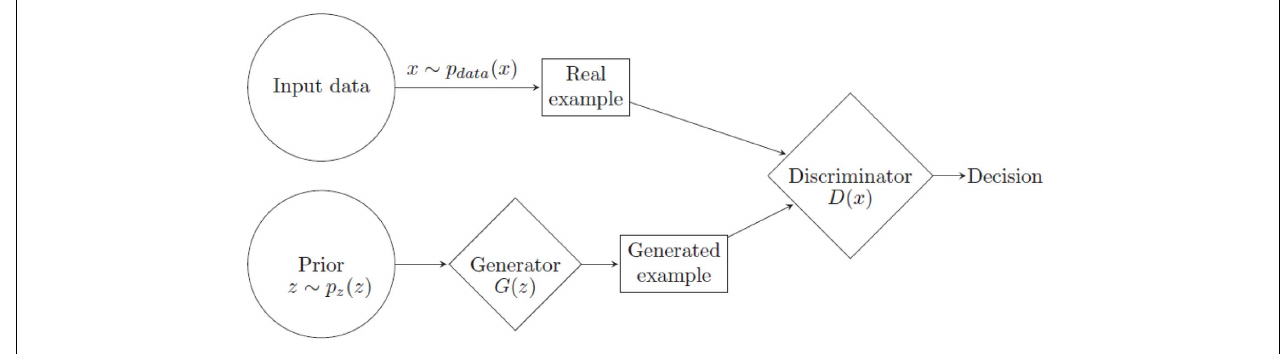
FIGURE 4 | Real input datapoints x and examples generated from a prior distribution by network G are fed to discriminator D for